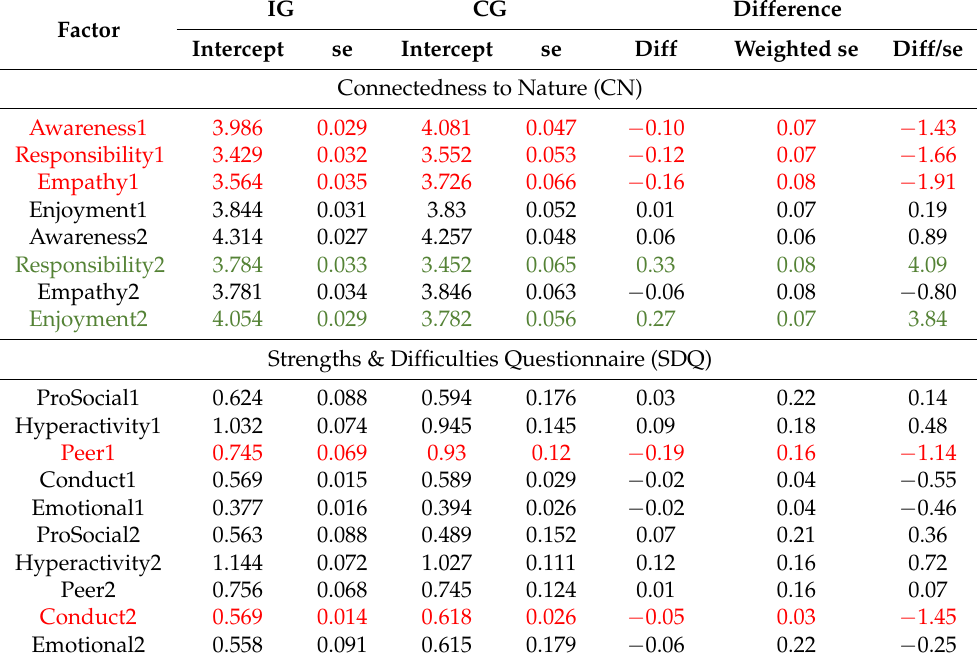
Table 2. Intercept values for CN and SDQ